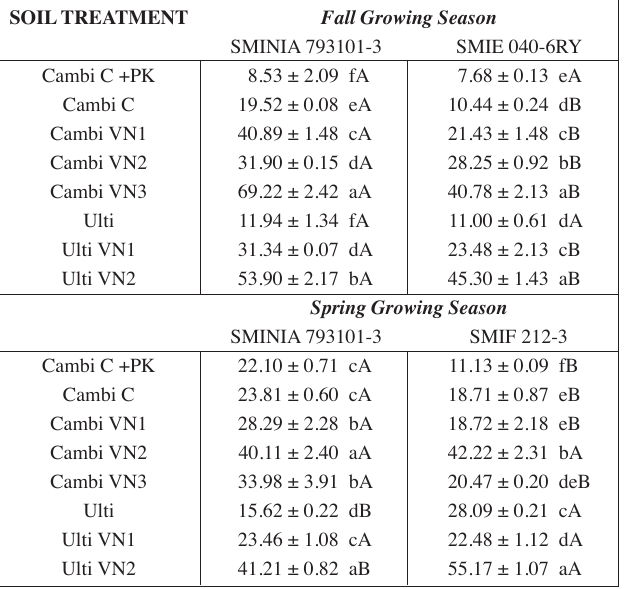
Tab. 3: Effect of increasing Cu level on tuber accumulation index (TAI)* in potato genotypes grown in vineyards soils. SOIL TREATMENT